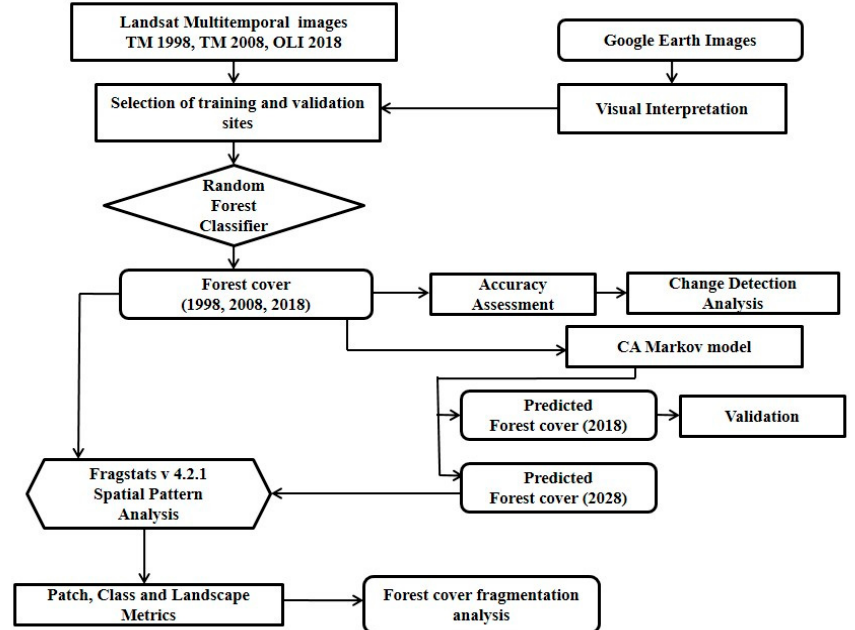
Figure 2. Flowchart depicting the methodology used in this study.